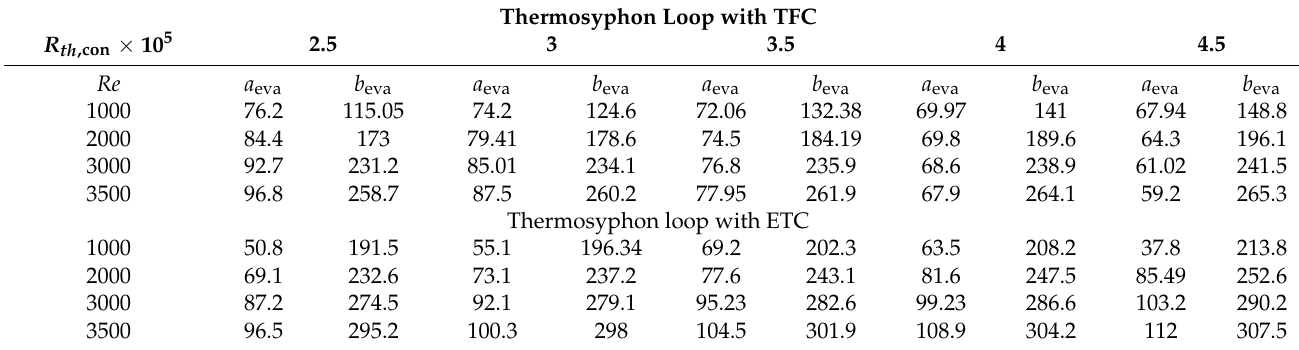
Table 2. Coefficients of a eva and b eva in Nu eva correlation.